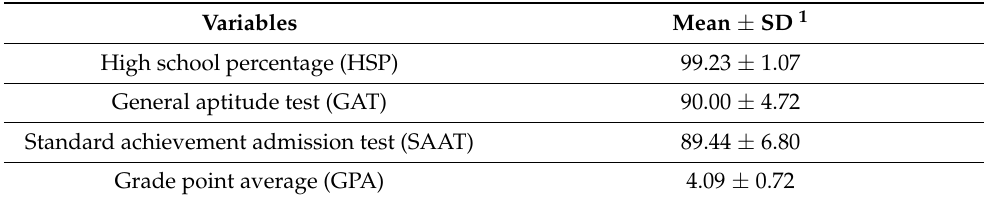
Table 1. Descriptive statistics.